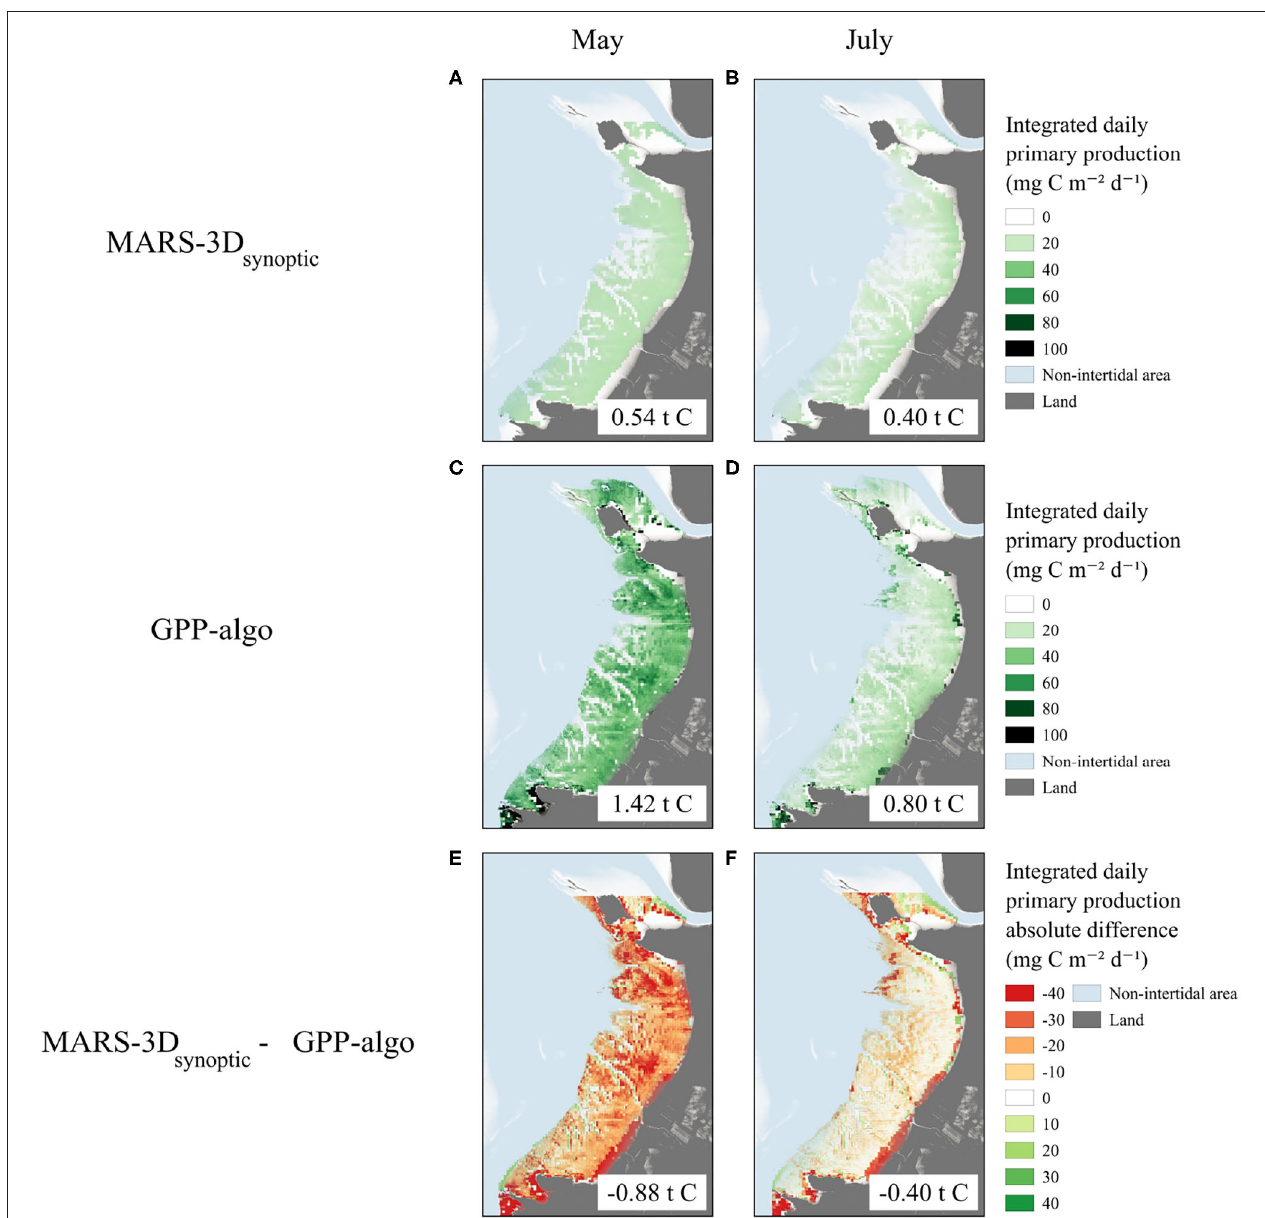
FIGURE 9 | Daily integrated GPP (mg C m − 2 d − 1 ) (A,B) simulated in the MARS-3D synoptic run on satellite acquisition matching days, (C,D) computed with the GPP-algo developed by Méléder et al. (2020), and (E,F) absolute differences of daily integrated GPP between MARS-3D synoptic and GPP-algo in May and July 2015. Values indicated in white frames correspond to the GPP spatially integrated over the mudflat in t